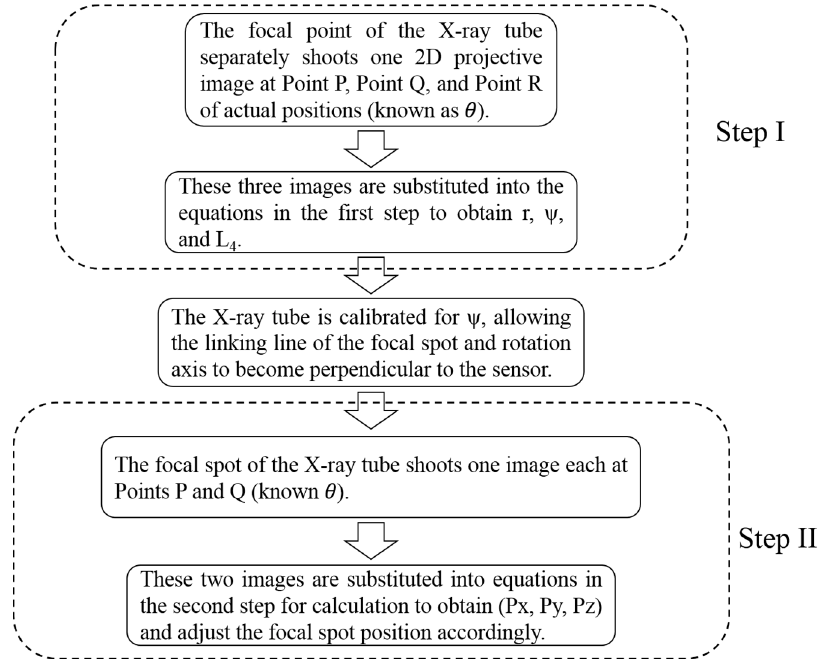
Figure 3. Two-step calibration process. The calibration method proposed in this study is conducted in two steps. In Step I, the focal spot of the X-ray tube is rotated and adjusted so that the linking line between the focal spot and the rotation axis is orthogonal to the sensor. From Step I: parameters r (distance of the focal spot of the X-ray tube to Point R), ψ (included angle between the linking line formed by Point P and Point R and the straight line orthogonal to the sensor), and L 4 (distance between the rotation axis position and the phantom) can be calculated. In Step II, the linking line of the focal spot is adjusted so that the rotation axis is orthogonal to the sensor at its center. From Step II: parameters Px (focal spot x-coordinate value), Py (focal spot y-coordinate value), and Pz (focal spot z-coordinate value) can then also be calculated.